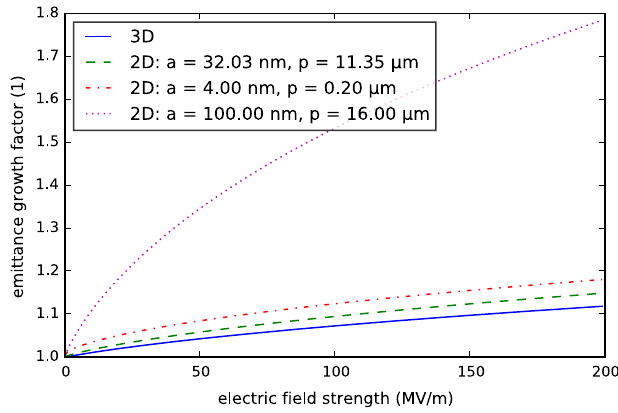
FIG. 13. Comparison between 2D and 3D emittance growth factor. The solid blue curve is calculated from the 3D rough surface shown in Fig. 10. The dashed green curve is calculated from the roughness parameters which are matched to the 3D rough surface. The dash-dotted red curve and the dotted magenta curve are calculated from the microroughness and macrorough- ness parameters from Table II,